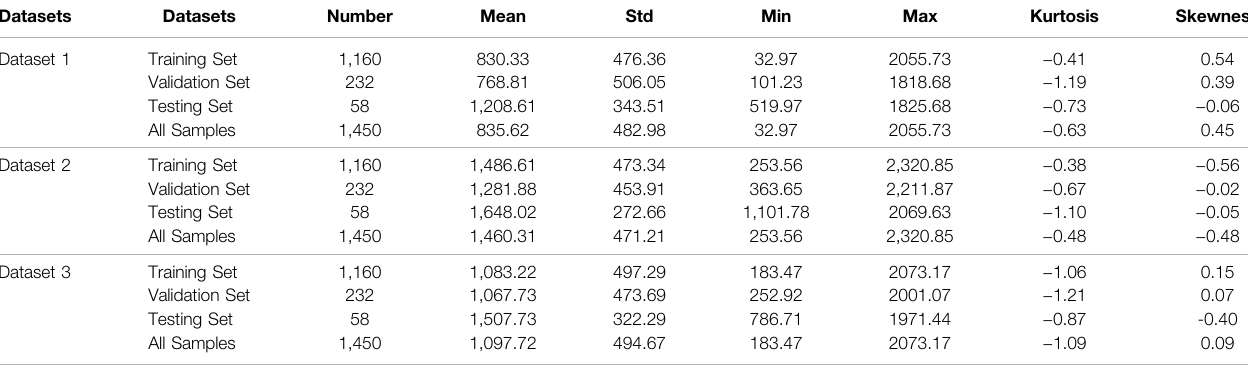
TABLE 3 | Relevant data characteristics of three datasets.